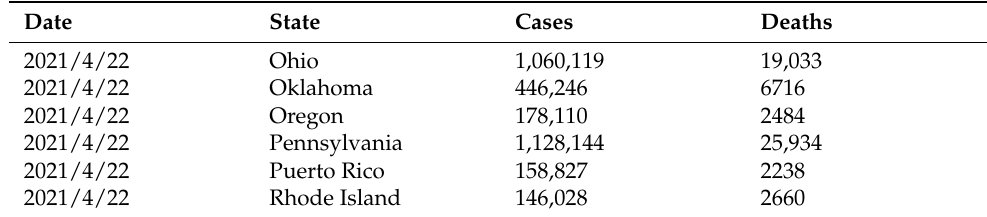
Table 1. The structure of the cases and deaths